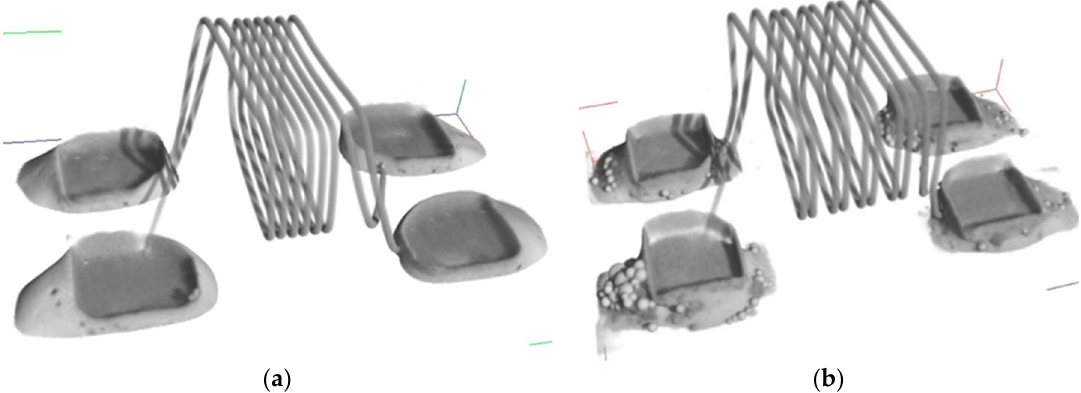
Figure 11. 3D CT scan of the component with ( a ) SCAN solder paste and ( b ) with Sn nano reinforced SCAN solder paste.